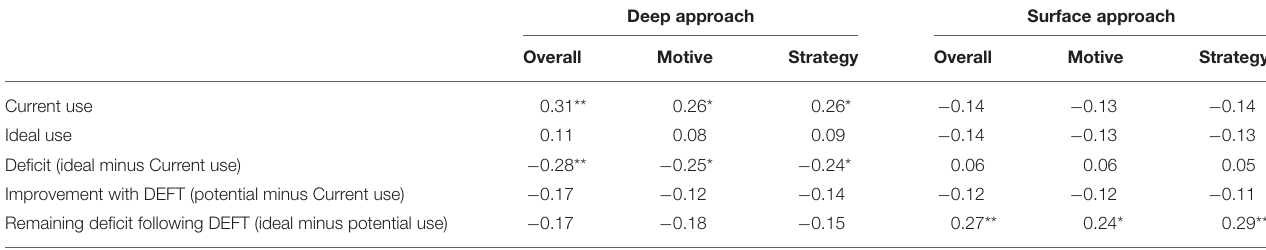
TABLE 1 | Spearman correlations between participants’ reported approaches to learning, and their perceptions of feedback usage with and without use of the DEFT.